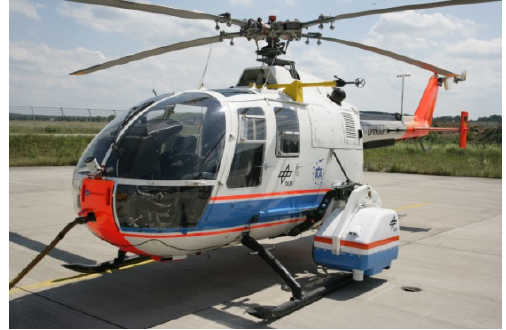
Figure 1. 4k system mounted on the helicopter BO-105